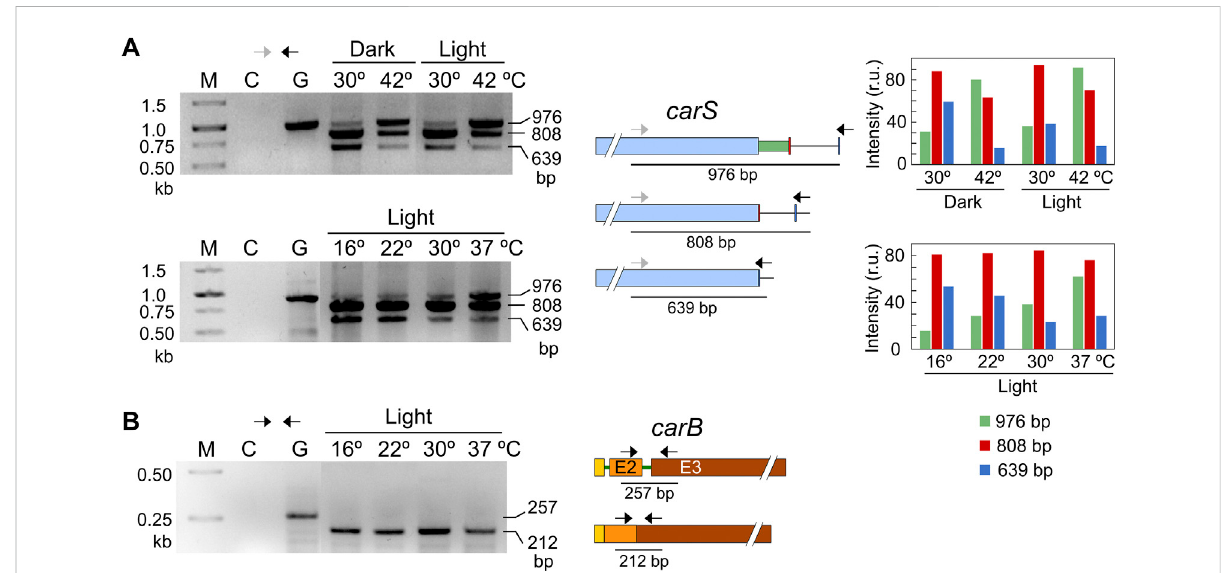
FIGURE 8 Effect of temperature on mRNA splicing. (A) PCR tests of the effect of temperature on splicing in carS mRNA in response to temperature. CulturestransferredtoPetridisheswereincubatedfor1 hourat30 ° Cinthedarkforadaptationandincubatedafterwardsforanadditionalhouratthe indicated temperature. The correspondence of the bands with the alternative splicing events is shown on the right scheme. In this case, the higher distancebetweentheprimersresultsinlargerPCRproductscomparedtoFigure7.Densitometryanalysisoftheindicatedbandsisshownonthe right. Intensity of each band is represented with a different color: green, 976-bp band (intron retention); red, 808-bp band (168-bp spliced intron); blue, 639-bp band (336-bp spliced intron). (B) Effect of temperature on the splicing of the second intron of carB gene, which does not exhibit alternative splicing according to RNA-seq data. In the three electrophoresis pictures: M, Size markers; G, Genomic DNA; C, Control without